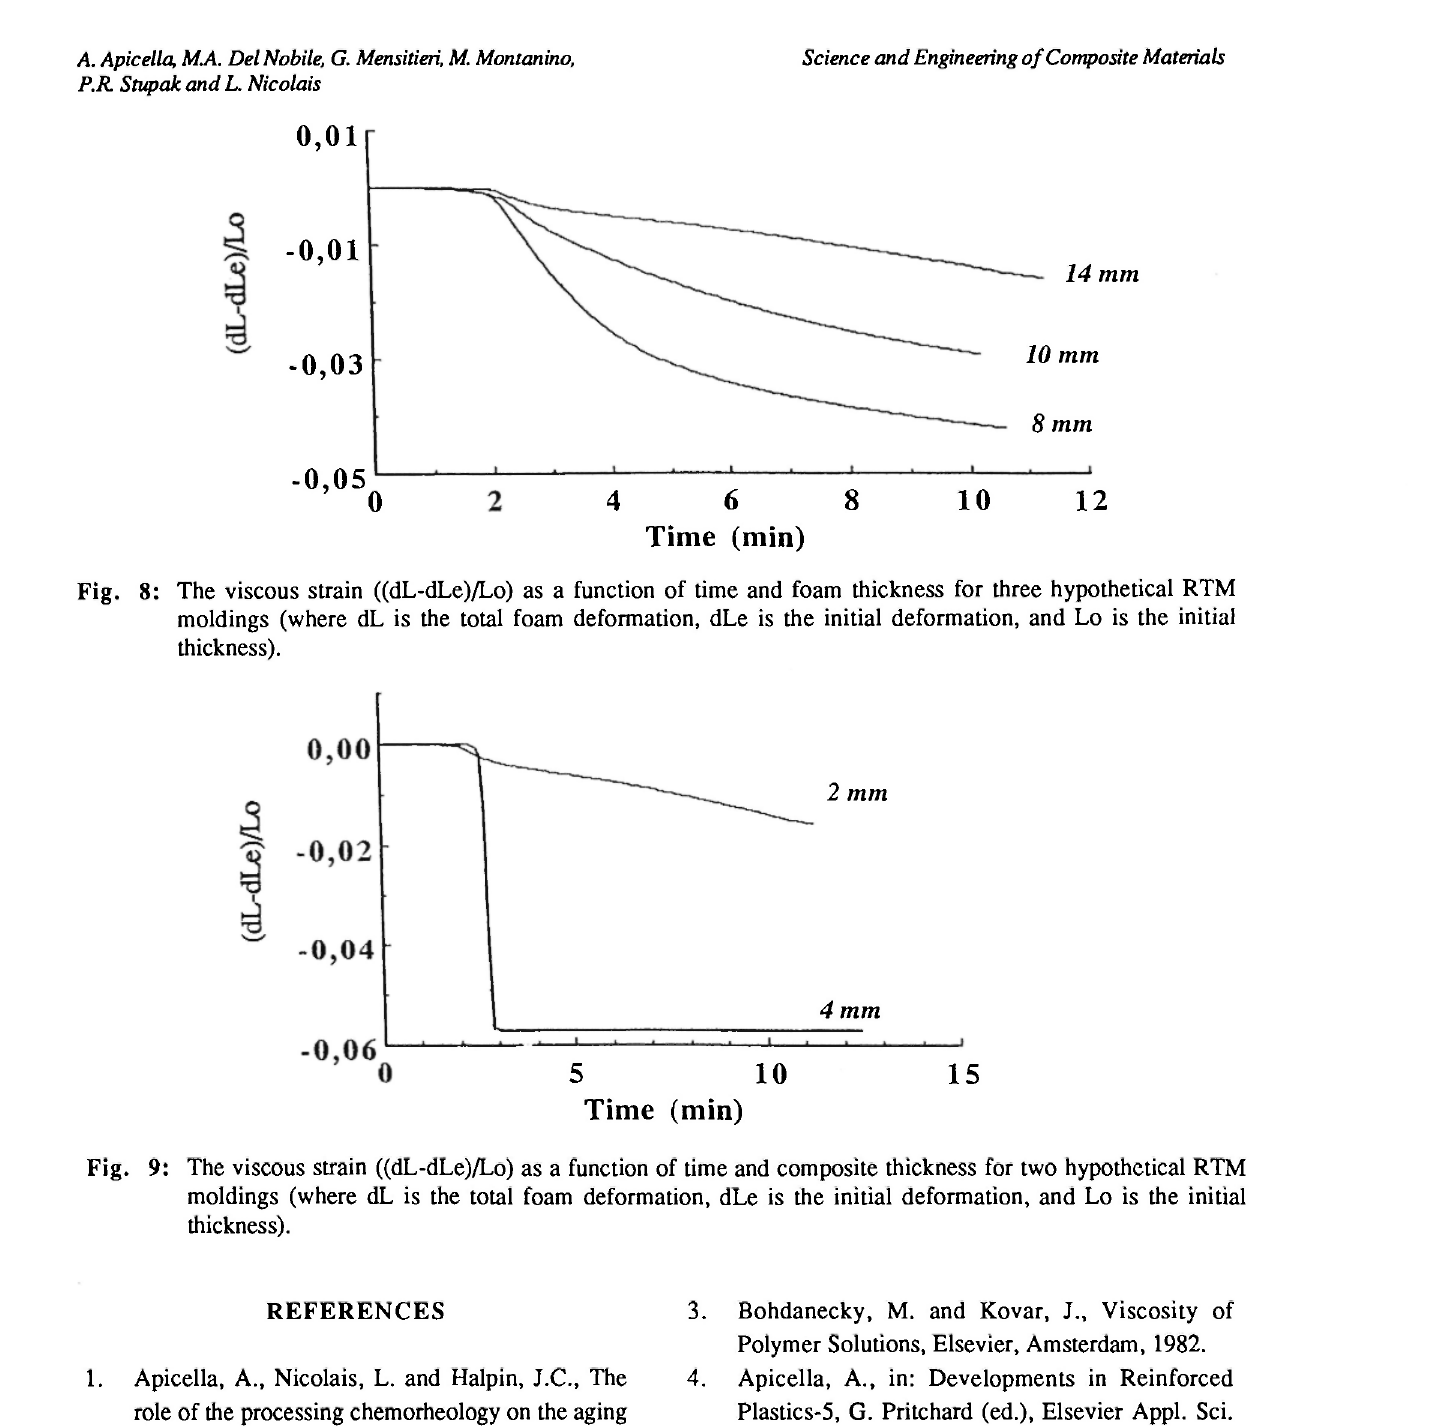
Fig. 9: The viscous strain ((dL-dLe)/Lo) as a function of time and composite thickness for two hypothetical RTM moldings (where dL is the total foam deformation, dLe is the initial deformation, and Lo is the initial